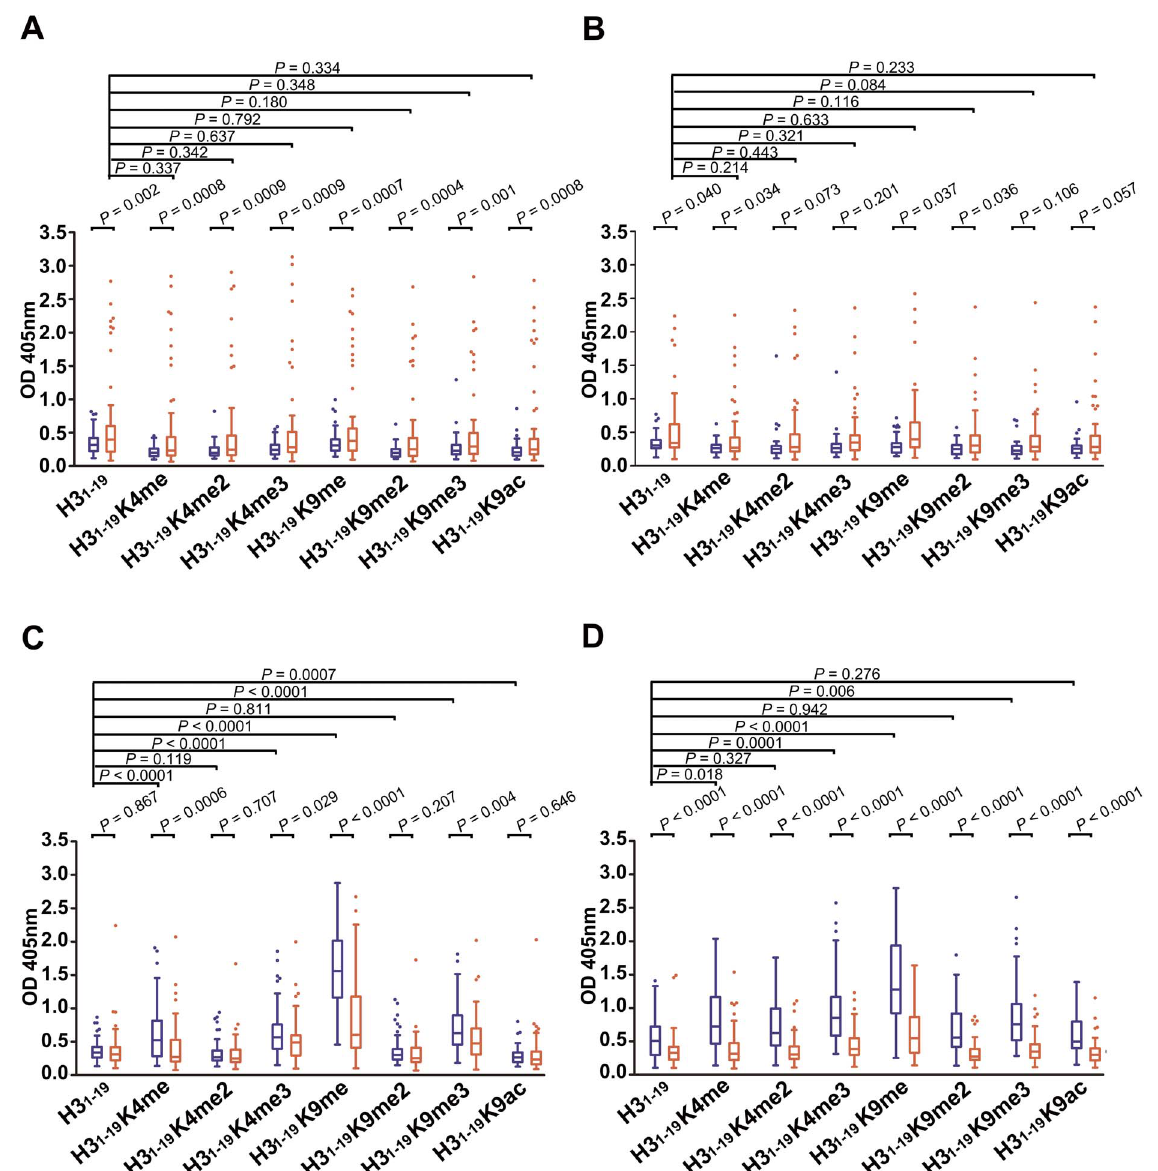
Figure 1. Reactivity of serum IgG and IgM against non-modified and modified H3 peptides. Microtiter plates were coated with peptides conjugated to BSA. Serum samples from healthy controls or SLE patients were diluted 1:100 and tested. KT47 anti-human IgG and KT16 anti-human IgM mAbs were used as primary Abs, and HRP-conjugated goat anti-mouse IgG was used as a secondary Ab (see Materials and Methods). The data are presented by box-blot diagram. (A) IgG anti-peptide Abs of pediatric samples. (B) IgG anti-peptide Abs of adult samples. (C) IgM anti-peptide Abs of pediatric samples. (D) IgM anti-peptide Abs of adult samples. Healthy controls are represented in blue and SLE patients are represented in red. P values between the healthy control and SLE groups were calculated using the Student’s t test. P values within the same groups were calculated using the paired t test.